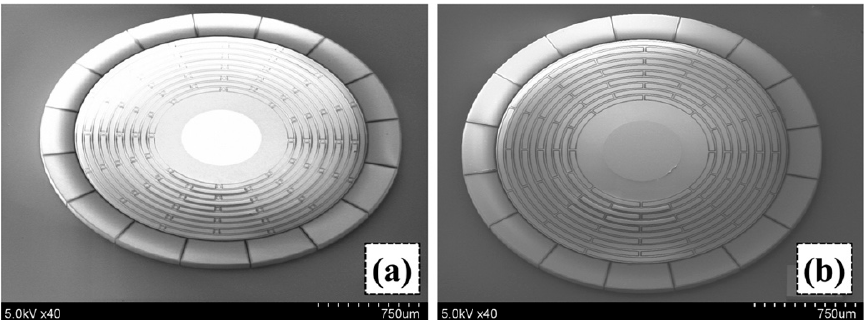
Figure 12. SEM images showing three-dimensional manufactured ( a ) designed resonator with elliptic spokes, and ( b ) conventional resonator with linear spokes.